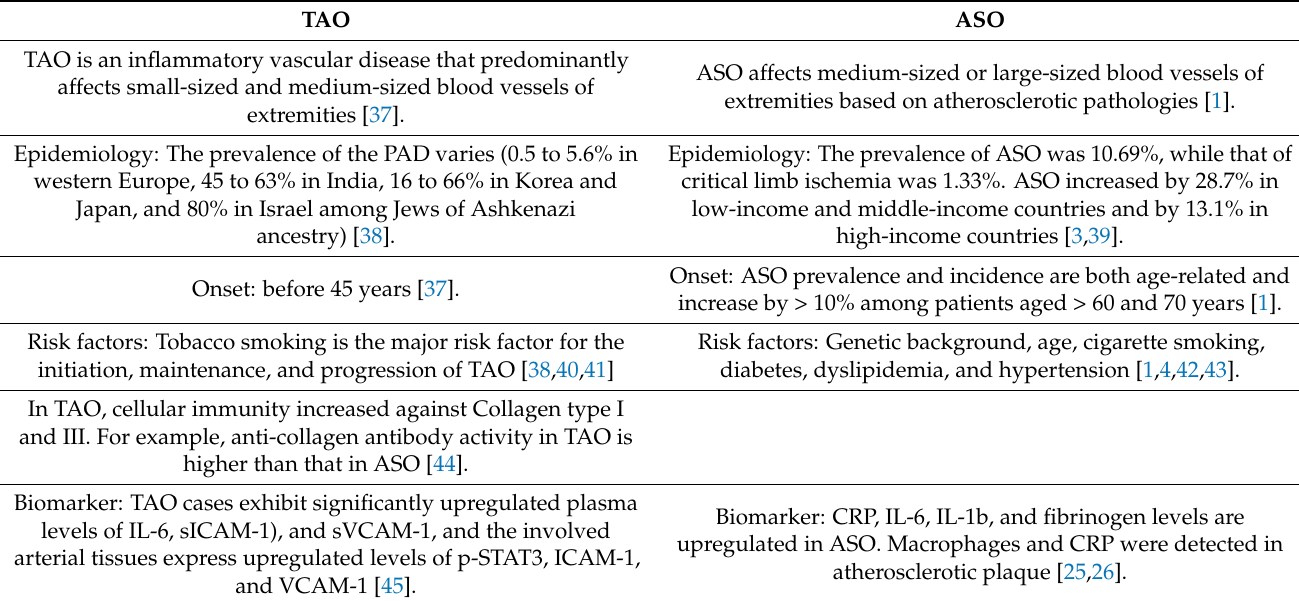
Table 4. Comparative features of TAO and